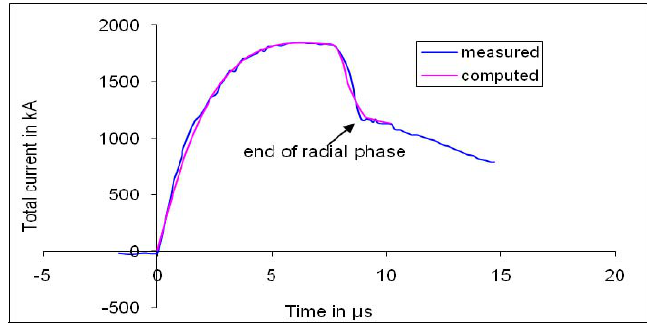
Figure 5. Fitting computed current to measured current traces to obtain fitted parameters f = 0.13, f = 0.7, f = 0.35 and f = 0.65. The measured current trace was for the PF1000 m c mr cr at 27 kV, storage capacity of 1332  F and fitted static inductance of 33.5 